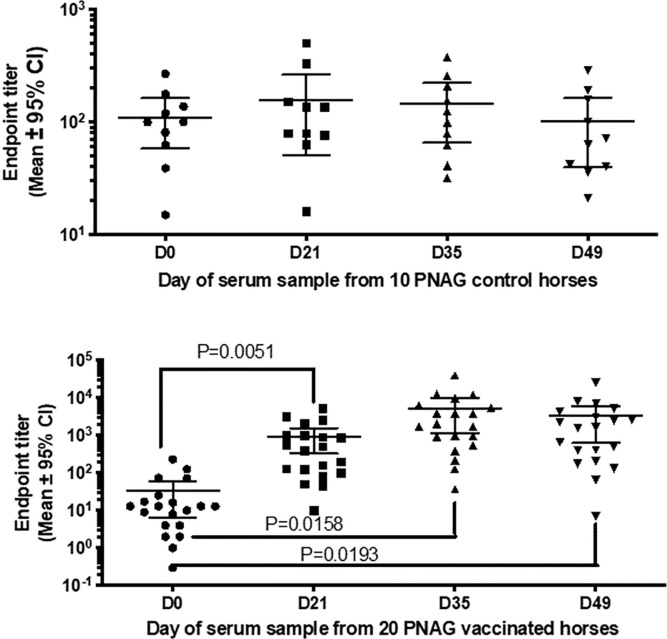
Immune responses of horses to IM immunization with the PNAG vaccine.Concentrations (endpoint titers) were unchanged over 49 days in control horses injected with saline (A) but were significantly increased from baseline (D0 = Day 0) at D21 after the initial vaccination, at D35 after a booster dose given at D21, and 14 days (D49) later among 20 PNAG-vaccinated horses (B). P values from multi-group comparisons in fixed-effects model.